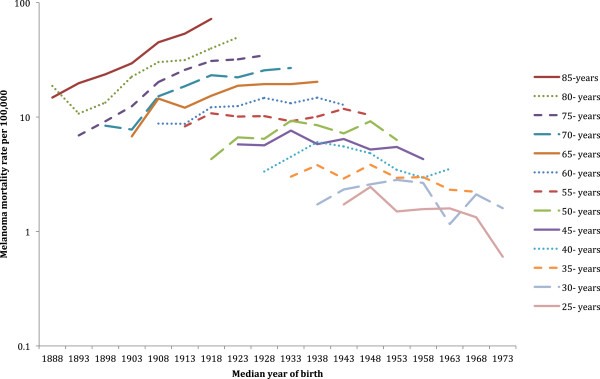
New Zealand melanoma mortality by 5-year age group and median year of birth. Both sexes combined. (y-axis on log scale).